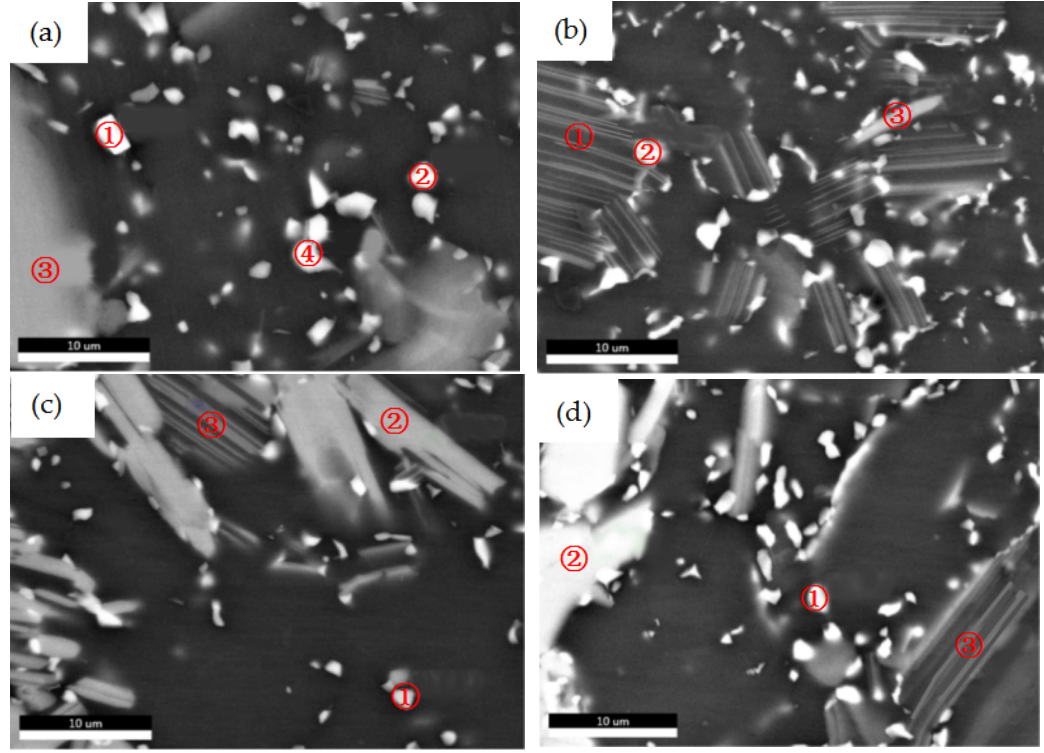
Figure 8. Energy Dispersive Spectroscopy (EDS) analysis selection map after different ageing treatments. ( a ) 190°C × 20 h. ( b ) 210°C × 20 h. ( c ) 230°C × 20 h. ( d ) 250°C × 20 h. Table 2. EDS results for the precipitated phases shown in Figure 8.